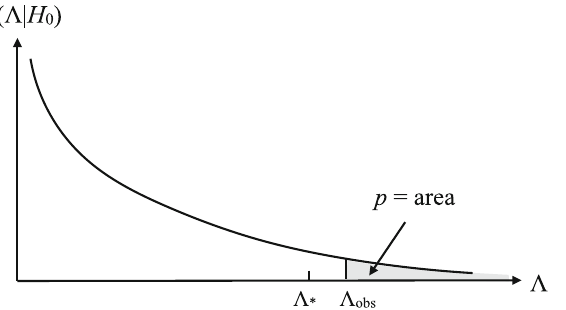
Fig. 3 Definition of the p -value (or significance) for frequentist hypothesis testing. The value of p equals the area under the probability distribution p ( Λ | H 0 ) for Λ ≥ Λ